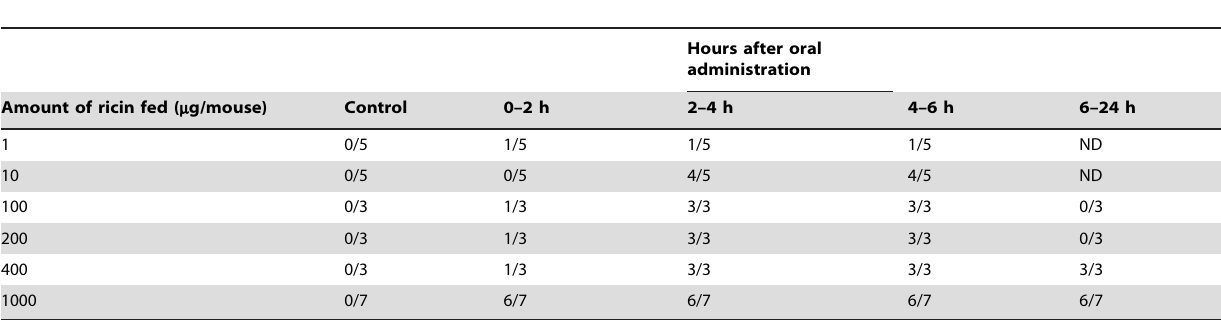
Table 4. Detection of ricin in mouse feces after oral administration using an IPCR